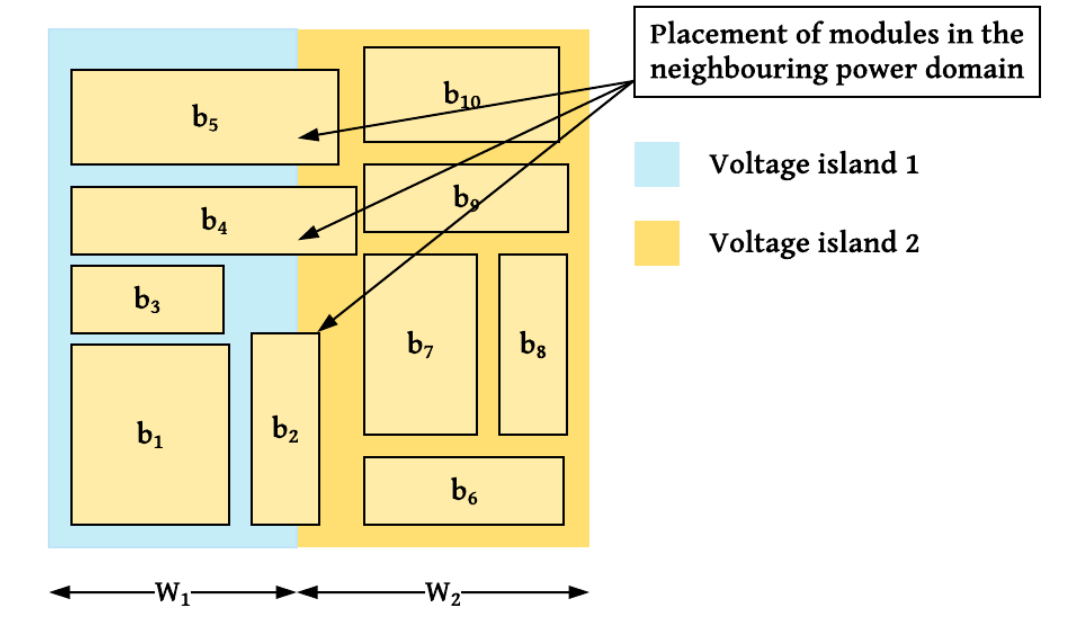
Figure 4. Placement of modules in the neighbouring power